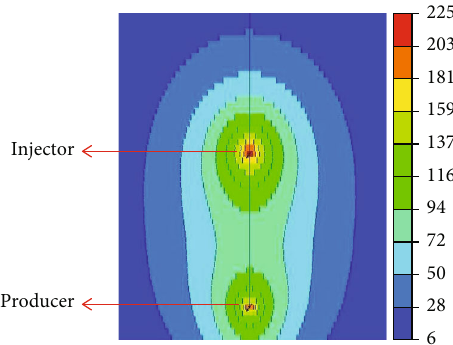
Figure 3: Simulated temperature fi eld during preheating period of dual horizontal wells.